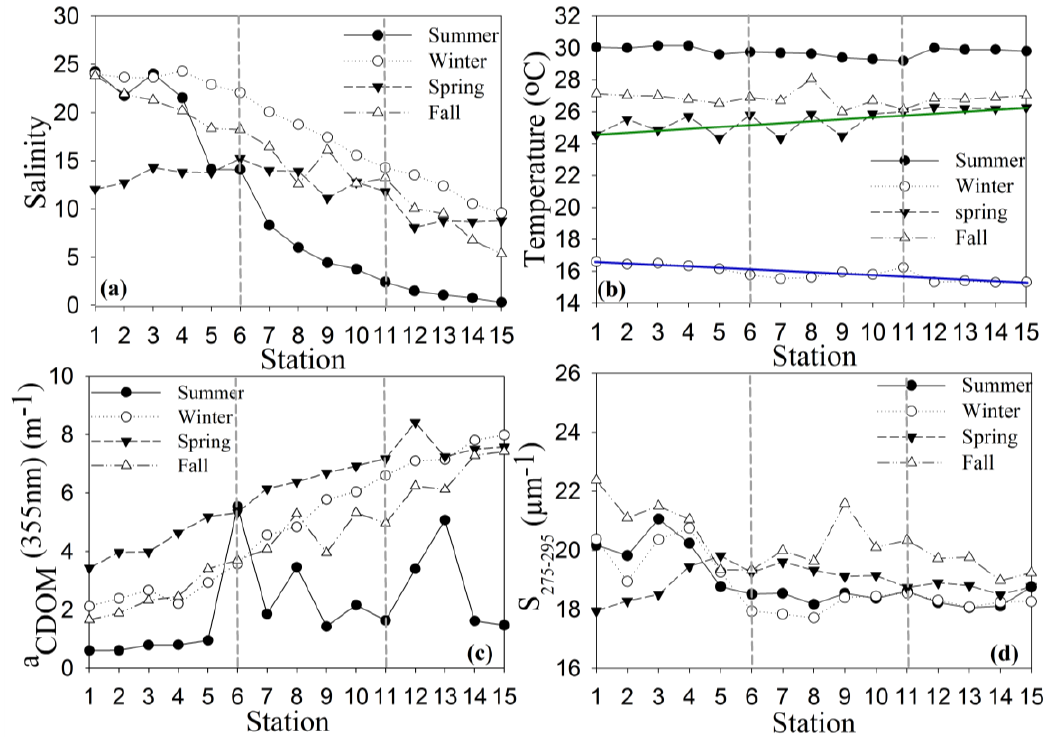
Figure 3. Mean ( a ) salinity, ( b ) temperature (solid lines represent trends), ( c ) CDOM absorption coefficient ( a g 355 ), and ( d ) CDOM spectral slope ( S 275–295 ) shown for Stations 1–15 (marine to freshwater end member) for summer (filled circles), winter (open circles), spring (inverted triangles) and fall (open triangle). Vertical dashed lines represent the different regions in Barataria Bay, namely: lower bay (Stations 1–5), central bay (Stations 6–10) and upper bay (Stations